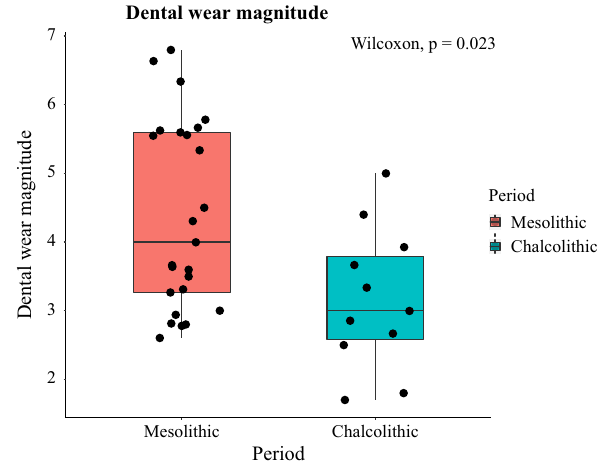
Figure 4: Dental wear magnitude ( scored according to Smith, 1984 ) of the Mesolithic and Chalcolithic